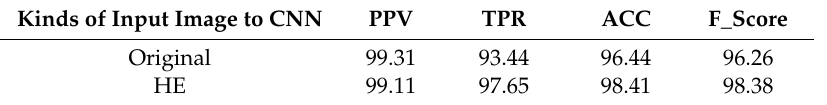
Table 8. Average testing accuracies of human and background detection with combined database (unit: %).